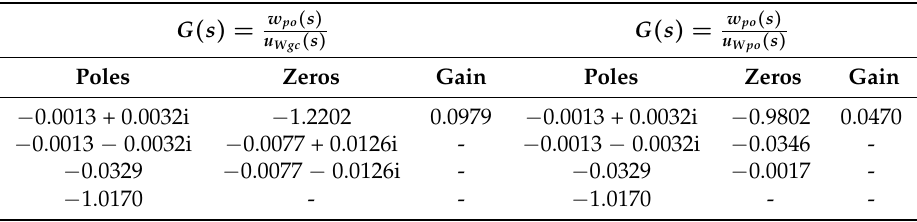
Table 5. Poles, zeros and gain of system transfer functions—Roja Soares’ model.